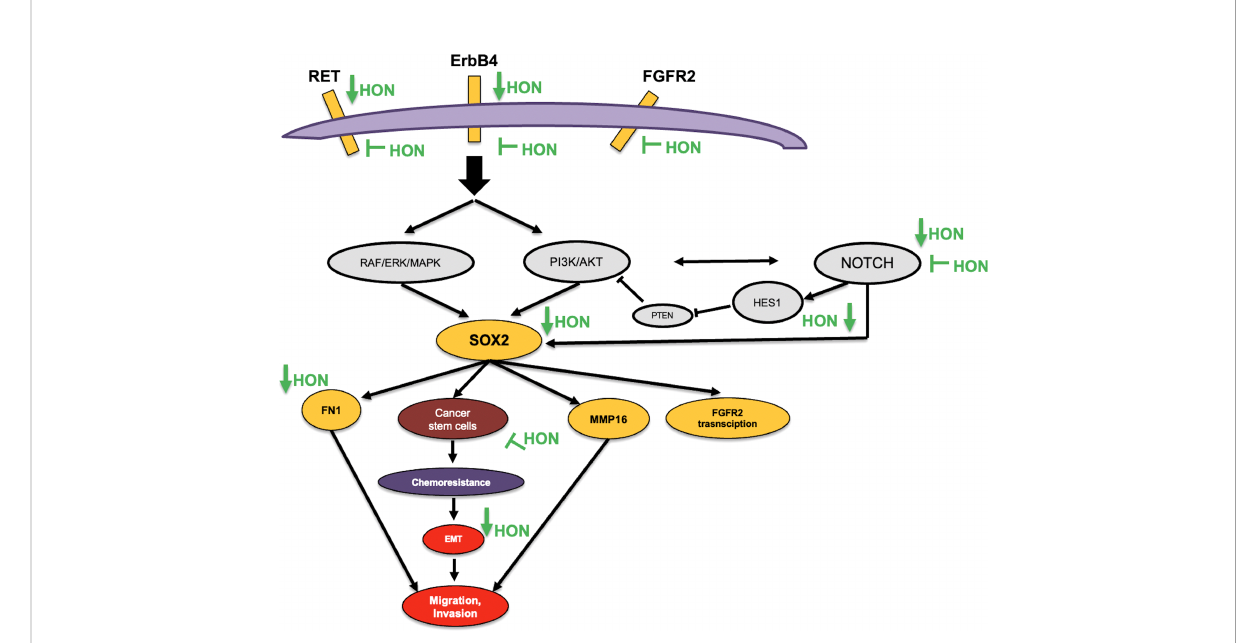
FIGURE 6 Proposed mechanism of HON in overcoming breast cancer resistance to